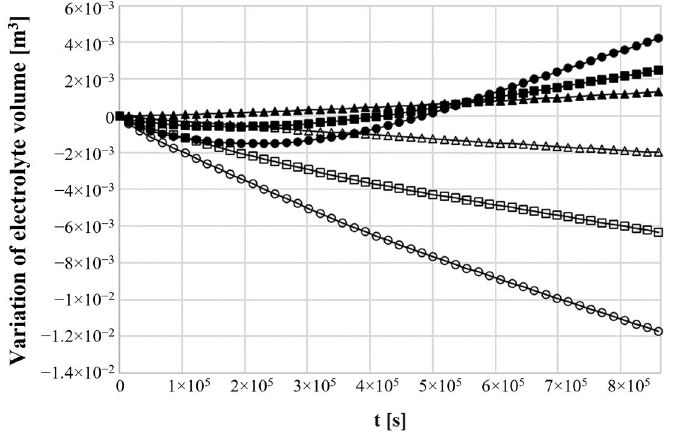
Figure 3. Temporal variation of anolyte (empty markers) and catholyte (filled marker) volume. Void ratio: 0.7 ▲ , 0.9 ■ , 1.2 ●.